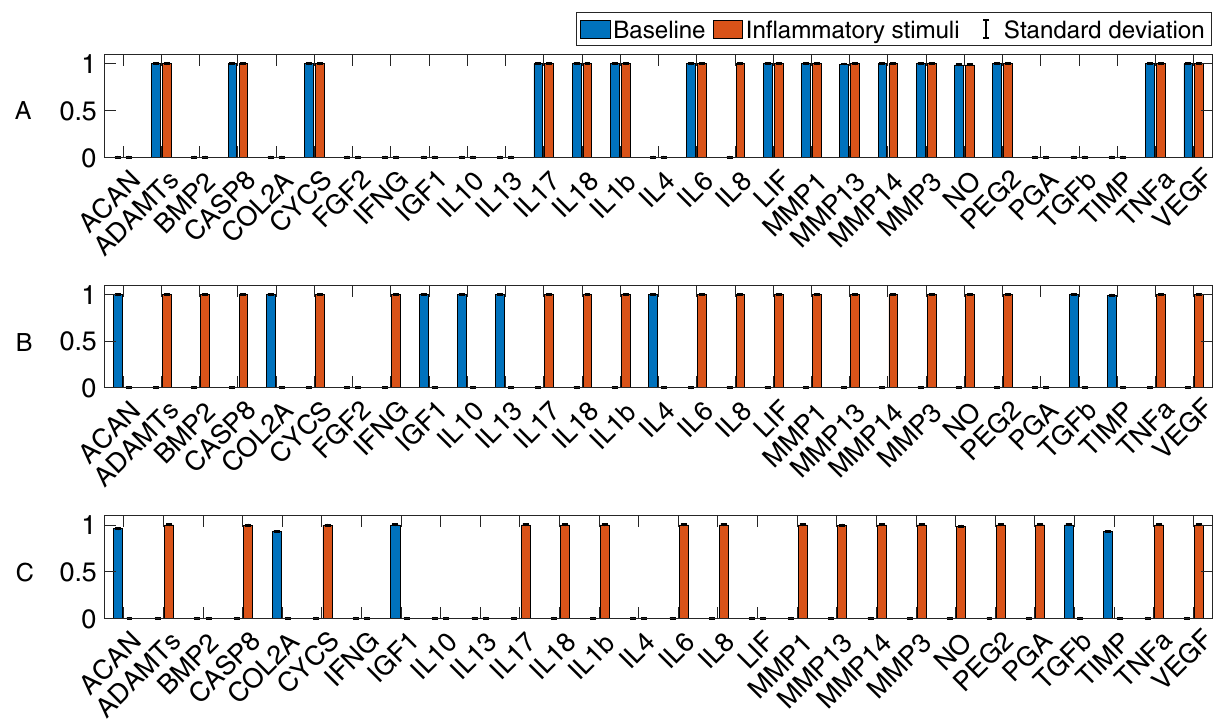
Figure 3. Final steady states of the baseline (blue) and proinflammatory stimulations (orange). The three networks developed are represented: ( A ) the literature-based network; ( B ) the enriched network; and ( C ) the optimized